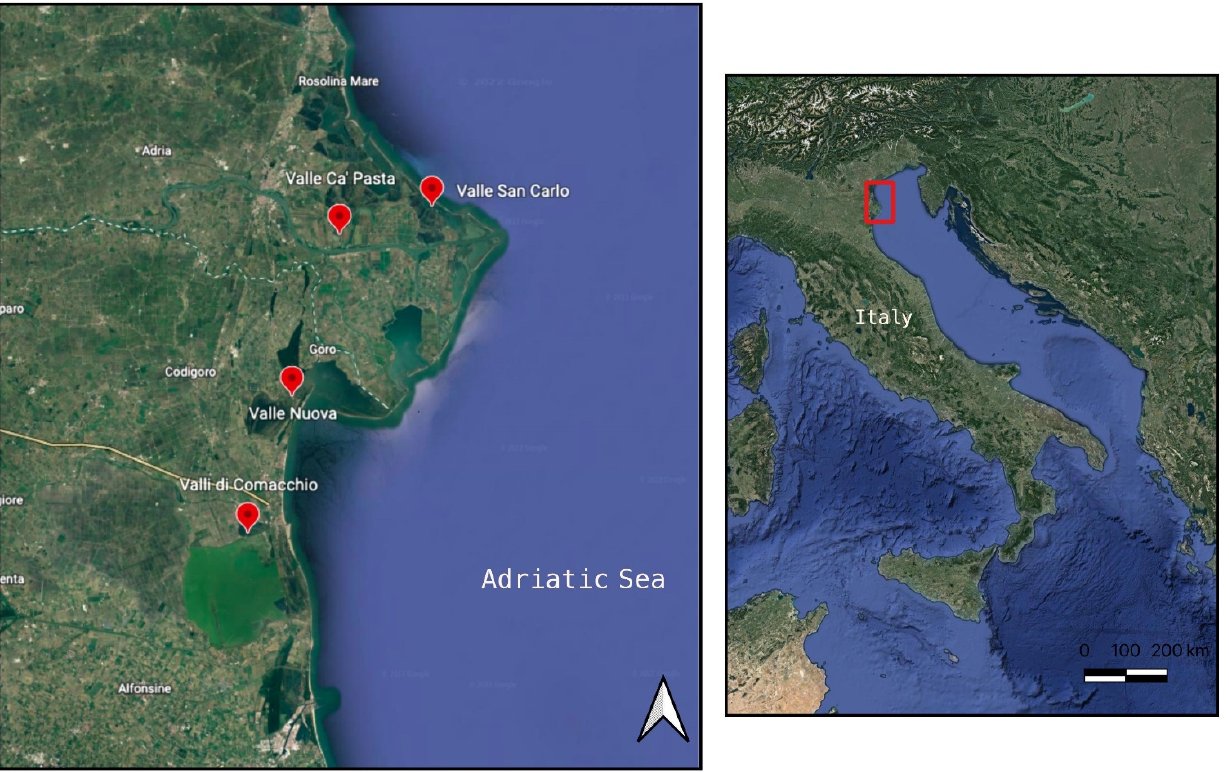
Figure 1. Map of the sampling areas in lagoons of the Northern Adriatic Sea. The map shows the four lagoons used for sampling: Valle di Comacchio (44°36 ′ 20 ″ N 12°10 ′ 11 ″ E), Valle Nuova (44°48 ′ 12 ″ N 12°15 ′ 16 ″ E), Valle Ca’ Pasta (44°58 ′ 07.7 ″ N 12°19 ′ 21.3 ″ E), Valle San Carlo (44°59 ′ 51.0 ″ N 12°27 ′ 21.3 ″ E).